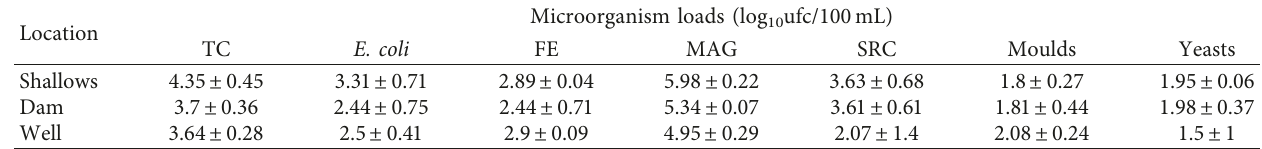
Table 1: Average loads of microorganisms according to sampling